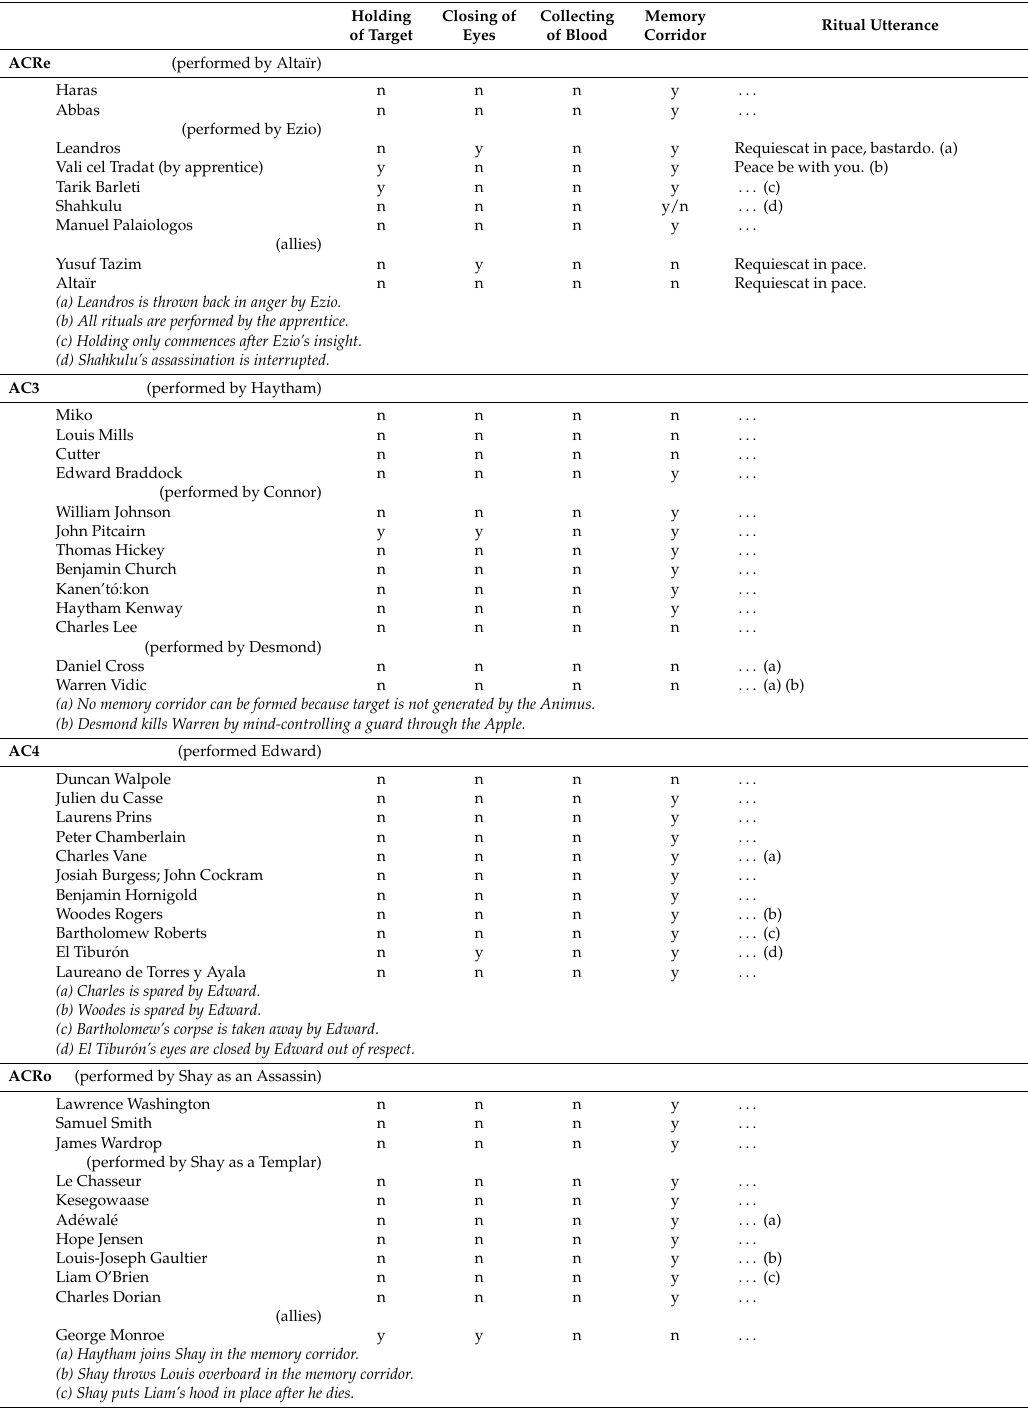
Table A1. Cont . Holding of